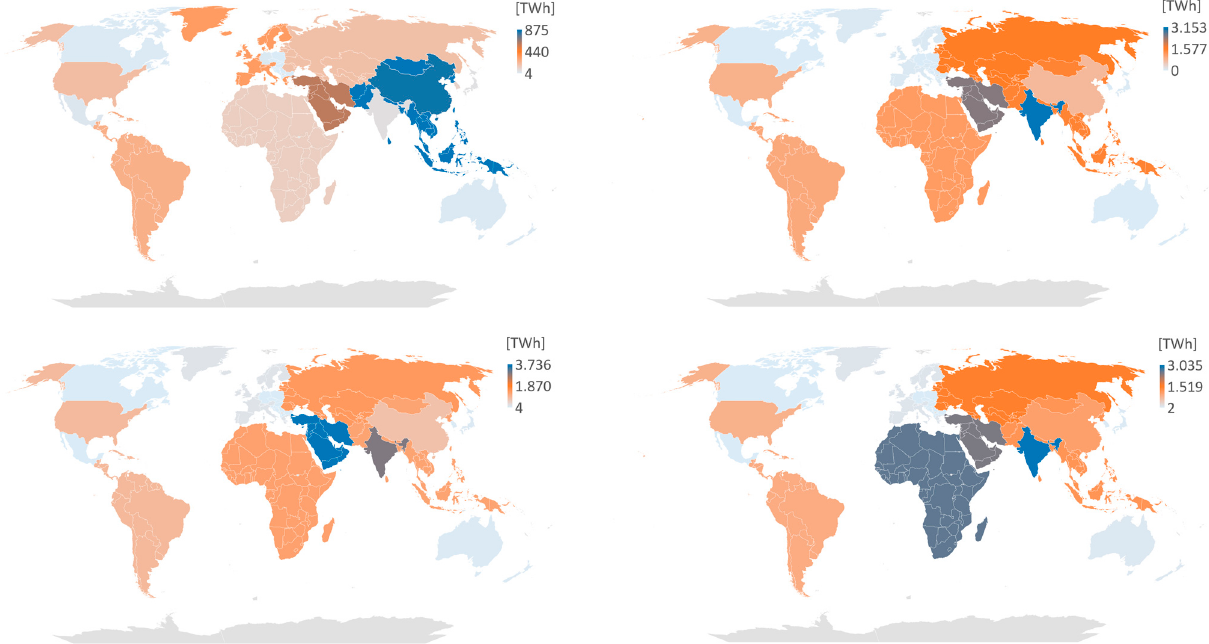
Figure 7. Hydrogen production along all scenarios in 2100. BAU is top left, 1_5D is top right, SoS1 is bottom left and SoS2 is bottom right.